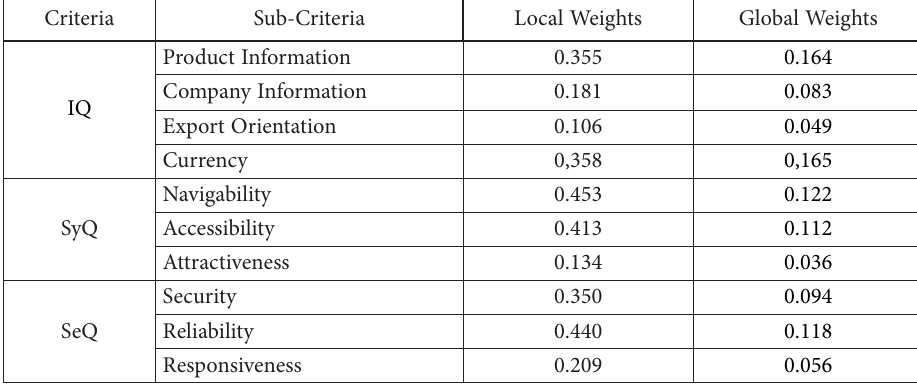
Table 4. Local and global weights of sub-criteria